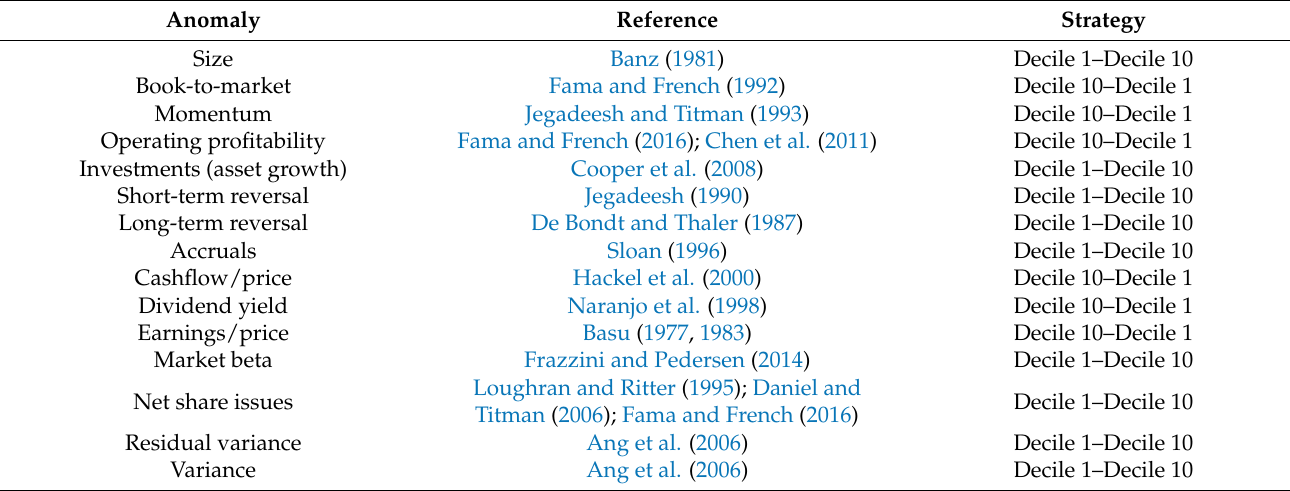
Table 2. Anomalies analyzed in this